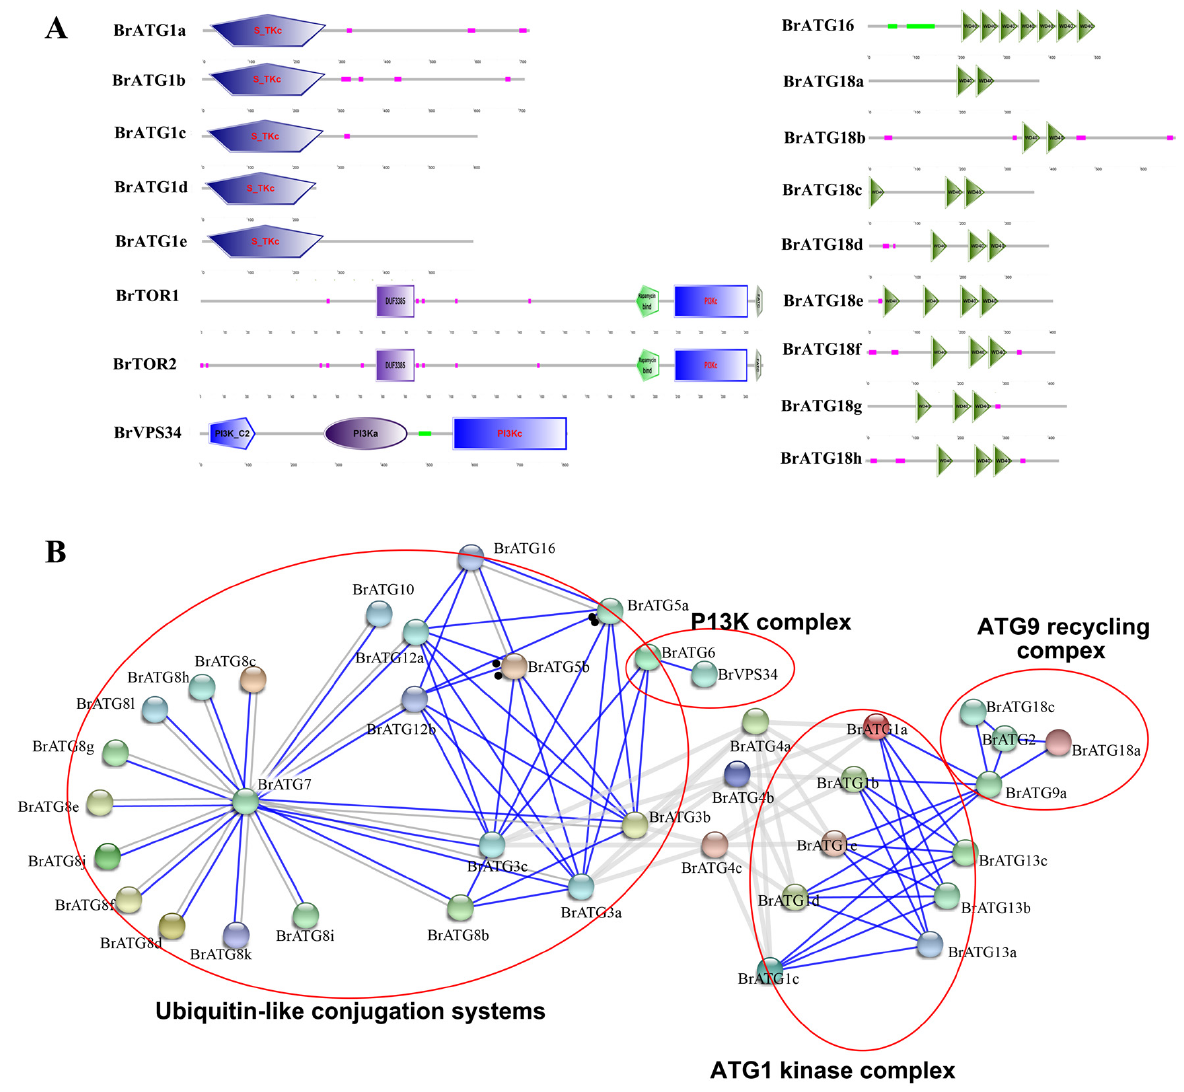
Figure 4. Conserved structural domains of BrATG protein ( A ), protein–protein interaction network (PPI) in BrATGs ( B ). Colored lines between proteins indicate evidence of various types of interactions.